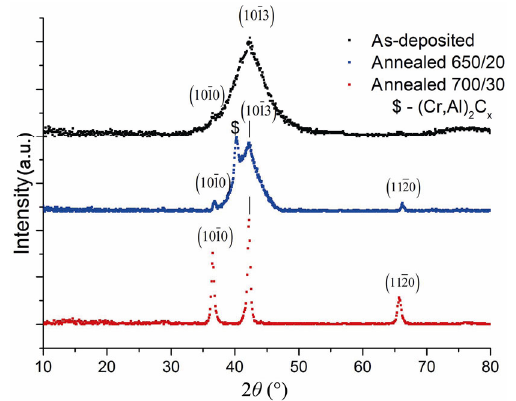
Fig. 5 Grazing-incidence XRD patterns of the samples: as-deposited (sample 1), annealed at 650 ℃ for 20 min (sample 1b), and 700 ℃ for 30 min (sample